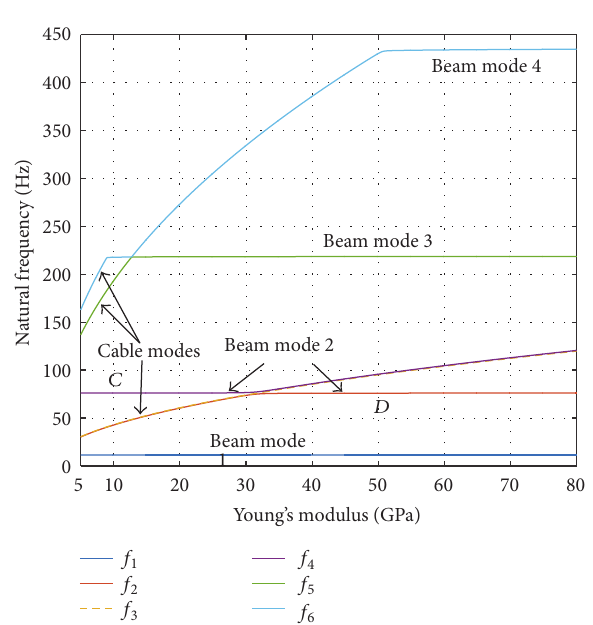
Figure 13: Variation of the natural frequencies with the cable’s Young’s modulus, 6 connections, and 𝑘 𝑙 = 10 5